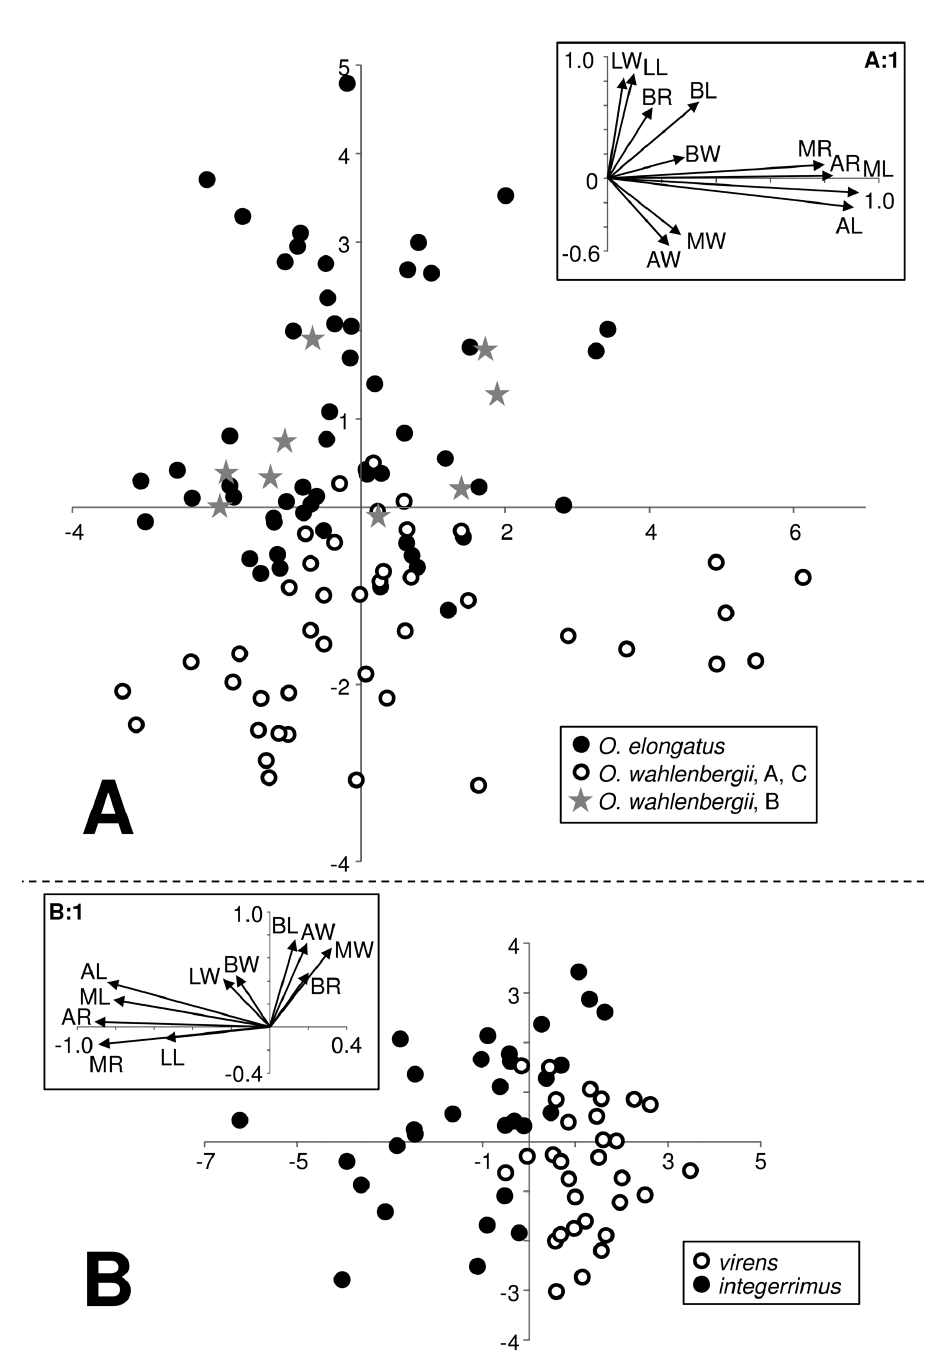
Fig. 2. The positions of three leaves from each of 18 molecularly identified specimens of O. elongatus, 14 of O. wahlenbergii A and C, and 3 of O. wahlenbergii B (cf. Fig. 1) ( A ), and of 10 specimens of O. virens and 10 of O. integerrimus Hedenäs sp. nov. ( B ), along the first two axes in a PCA. The PCA is based on each leaf’s length (LL), width (LW), and leaf lamina cell length, width, and length/width ratio in the apical (AL, AW, AR), middle (ML, MW, MR), and sheathing basal (BL, BW, BR) lamina. Cell measurements are the mean values of 20 cells per position in each leaf. Axes 1 (x) and 2 (y) explain 30.69% and 25.24% of the variation in A, and 32.56% and 22.01% of the variation in B. Insert diagrams A:1 and B:1 depict explanatory factors in the plane of these two